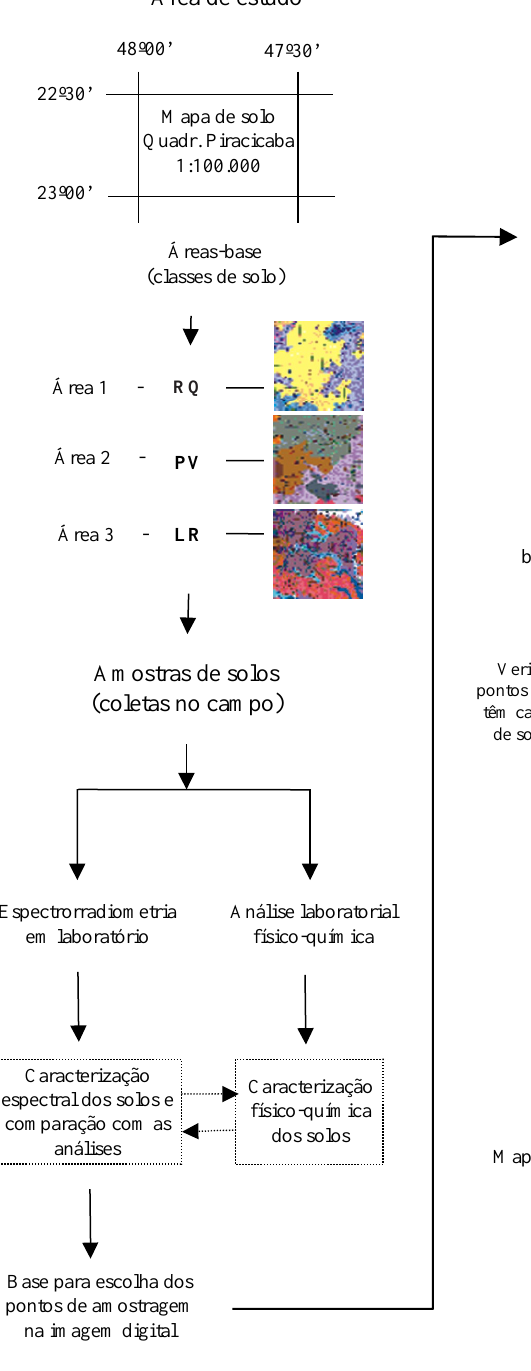
Figura 2. Fluxograma das atividades